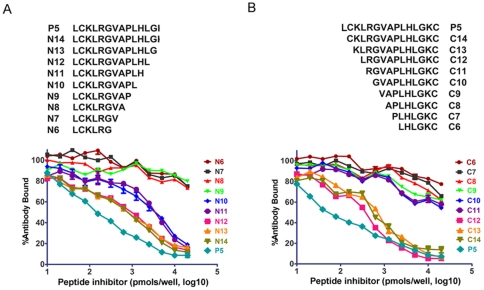
Inhibition of the binding of anti-P5 serum to parental peptide P5 by peptide homologs.Antiserum induced by the P5-KLH conjugate was tested by ELISA for its ability to bind to the P5 peptide in the presence of dilutions of peptides N6–N14 (panel A) or peptides C6–C14 (panel B).